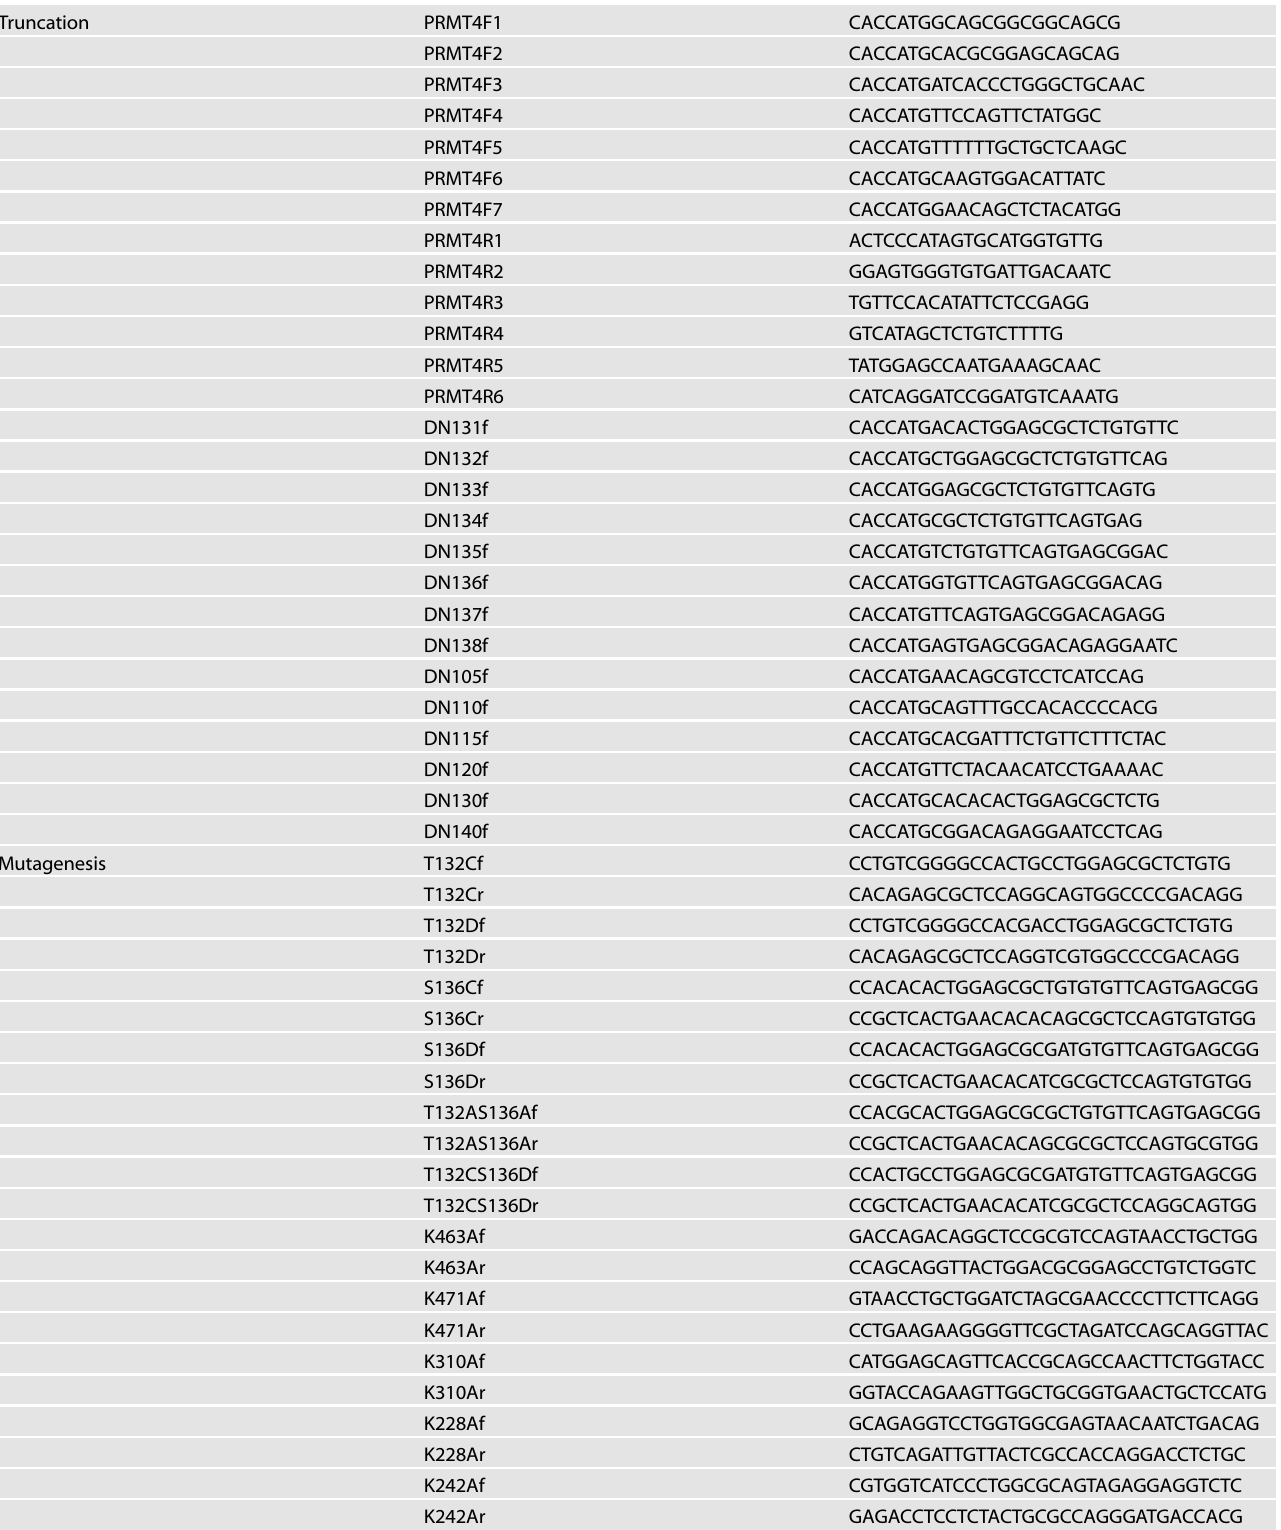
Table 1. Primers used in the